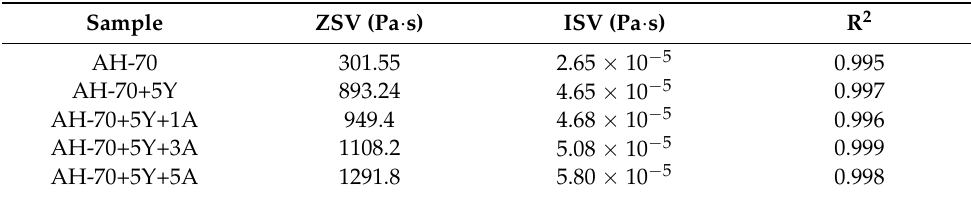
Table 4. Frequency scan test results (60 ◦ C).